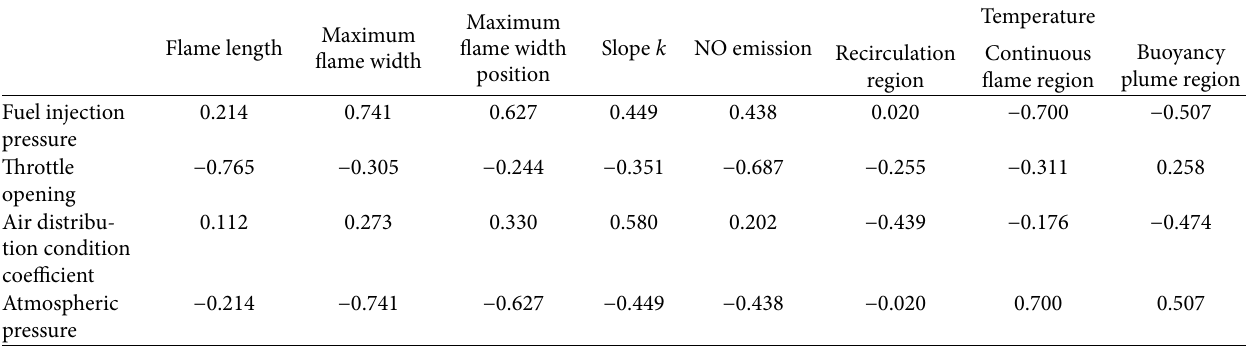
Table 3: Correlation